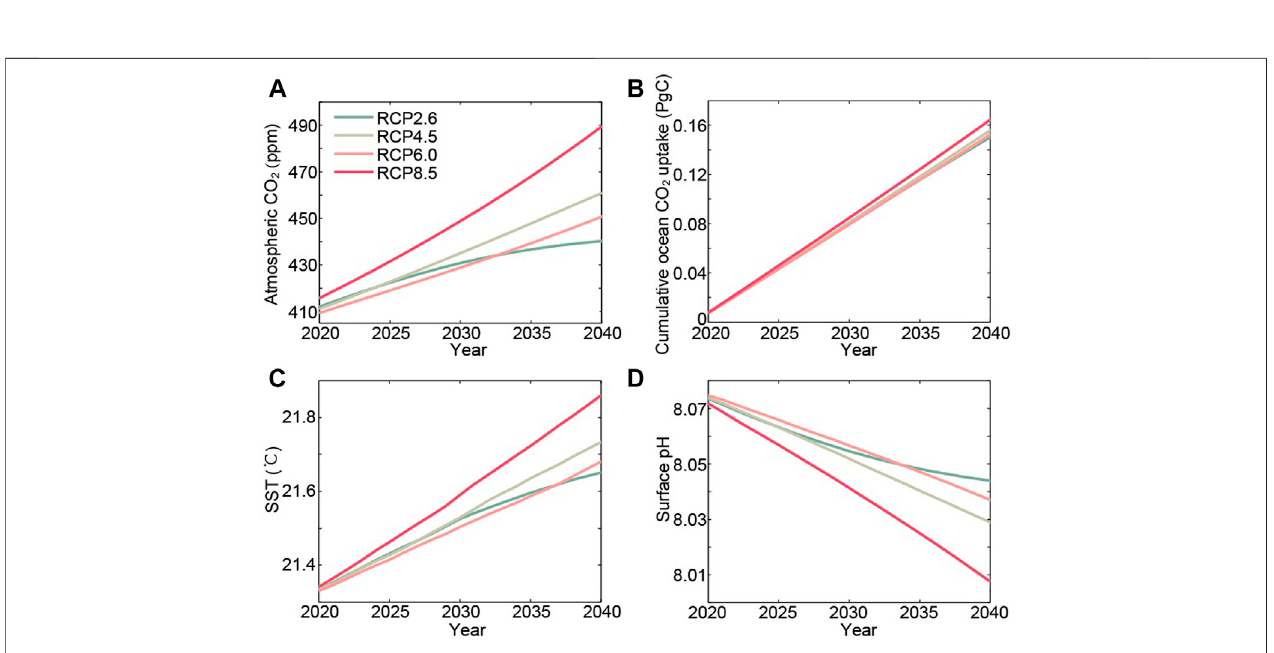
Frontiers in Physics |